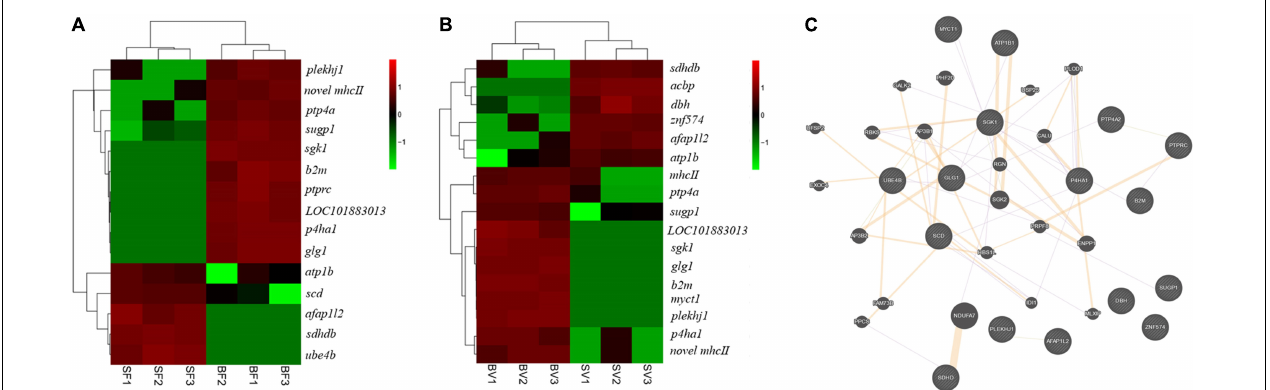
FIGURE 6 | Key genes related to early growth regulation in bone tissues of bighead carp. (A) Key genes related to early growth regulation in the frontal and parietal bones. (B) Key genes related to early growth regulation in the vertebral bones. The FPKM data of genes was used for heatmap construction. (C) The correlation network of key genes. The round nodes filled with diagonal lines indicate key genes related to early growth regulation in bone tissues. The round nodes filled with pure color indicate genes that interact with key genes. The interactions among different genes were represented by different colorful lines. Orange lines indicate predicted interactions. Purple lines indicate co-expression interactions. Gene abbreviations: pleckstrin homology domain-containing family J member 1 ( plekhj1 ), SURP and G-patch domain-containing protein 1 ( sugp1 ), prolyl 4-hydroxylase subunit alpha-1 ( p4ha1 ), novel MHCII β chain protein ( novel mhc II ), protein tyrosine phosphatase type IVA ( ptp4a ), β 2-microglobulin ( b2m ), serine/threonine-protein kinase Sgk1 ( sgk1 ), receptor-type tyrosine-protein phosphatase C ( ptprc ), uncharacterized protein LOC101883013 ( LOC101883013 ), myc target protein 1( myct1 ), golgi apparatus protein 1 ( glg1 ), sodium/potassium-transporting ATPase subunit β ( atp1b ), stearoyl-CoA desaturase ( scd ), dopamine β -hydroxylase ( dbh ), succinate dehydrogenase [ubiquinone] cytochrome b small subunit B ( sdhdb ), MHC class II β precursor ( mhcII ), actin filament–associated protein 1-like 2 ( afap1l2 ), acyl-CoA–binding protein ( acbp ), ubiquitin conjugation factor E4 B ( ube4b ), zinc finger protein 574 ( znf574